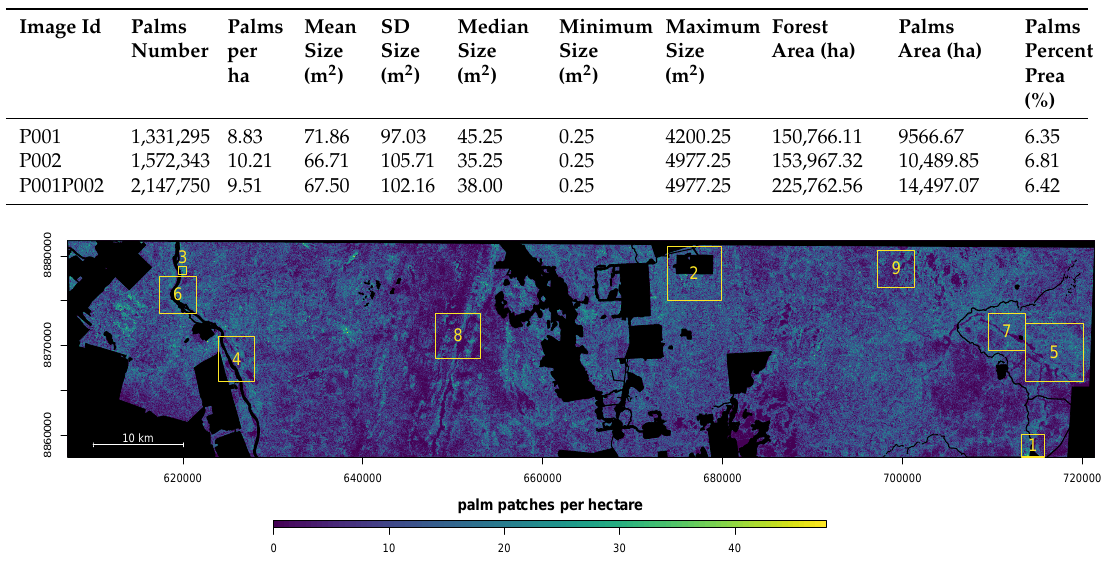
Table 1. Characteristics of the automatically delineated canopy palm patches (number, size and density) in the two GeoEye-1 images. The results are given for each image separately (P001 and P002) and then for the merged image of the whole scene (P001P002).